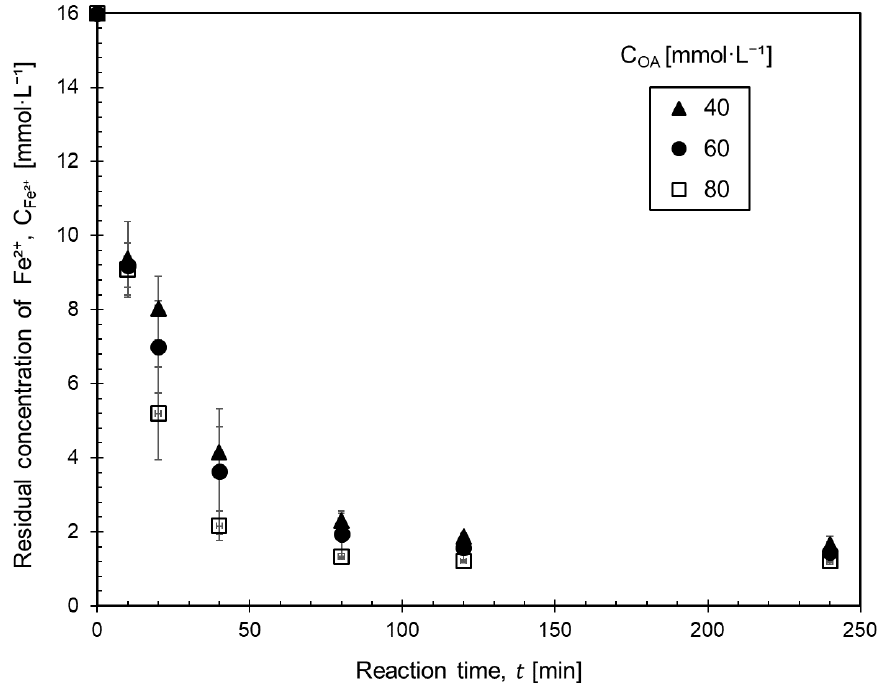
Figure 7. Effect of the concentration of oxalic acid ( 𝐶 𝑂𝐴 ) on the precipitation behavior of ferrous oxalate at 𝐶 𝐹𝐴𝑆 = 16 mmol·L − 1 and 25 °C.